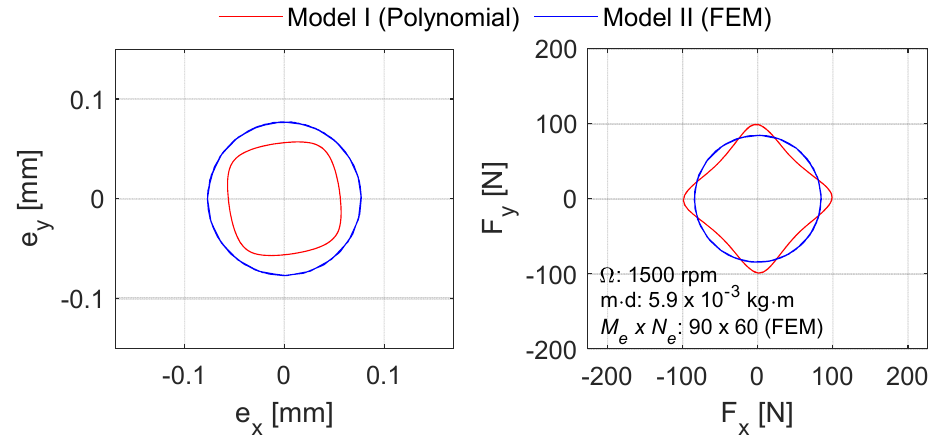
Figure 16. The orbits and bearing forces from the two simulation models.